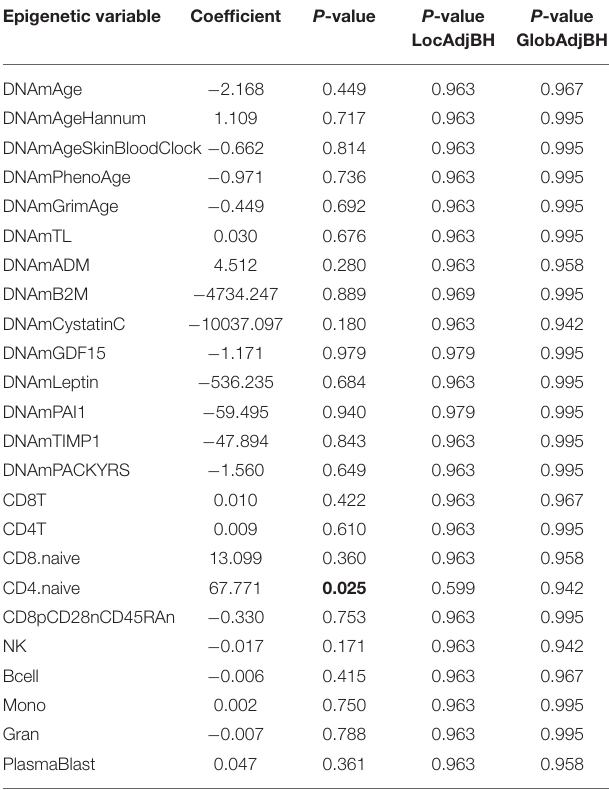
ThecolumnsreportthevalueofMLRcoefficient(“Coefficient”),thecorrespondingnominal p-value(“P-value”),thep-valuecorrectedwithBenjamini–Hochbergprocedureformultiple tests locally—within a single cohort (“P-value LocAdjBH”), and globally—within all the cohorts included in the study (“P-value GlobAdjBH”). Significant p-values are reported in